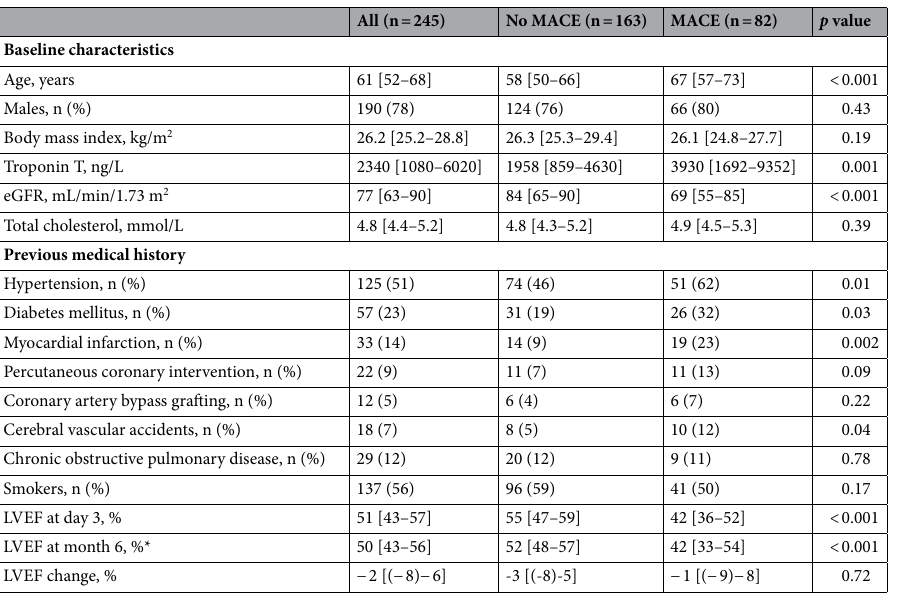
Table 1. Clinical characteristics of the patients. Continuous variables are expressed as mean ± SD for normal data or median [IQR] for non-normal data; dichotomous variables are expressed as number and percentage. eGFR estimated glomerular filtration rate, IQR interquartile range. p values represent the unpaired t -test analyses between MACE and no MACE for normal data and Mann–Whitney non-parametric test for non- normal data (troponin T and tumour necrosis factor α). * p < 0.05, time-effect month 6 vs. Day